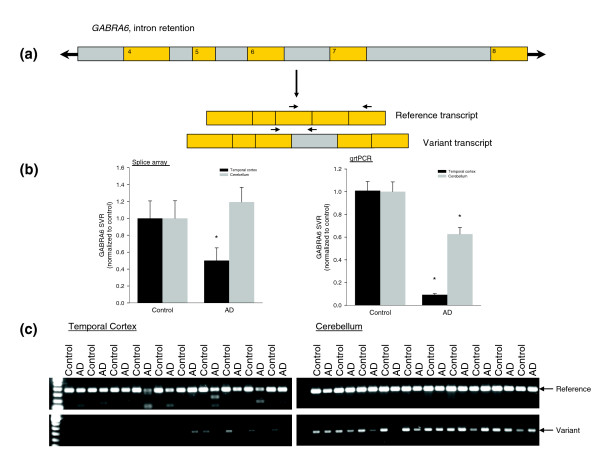
Representative AD-associated alternative splicing event identified using splice array technology. (a) Schematic of GABRA6 alternative splicing event associated with mTLE. Exons are shown in orange and intronic regions are shown in gray. (b) Data collected for the GABRA6 alternative splice event in control and AD brain tissue (TC and CB) samples using the splice array technology (left) and quantitative rtPCR (qrtPCR, right). Data are presented as mean ± standard error of the mean; *p < 0.05 when compared to control, Student's t-test. (c) rtPCR confirmation of the pattern of transcript expression in brain tissue collected from ten subjects from each group. Reference and variant transcript forms were amplified using the following primer sequences (indicated in the figure by arrows above mRNA transcripts): reference GABRA6F-AAGAATCTTCAAGCCTTCTCCA, GABRA6R-TGACAGCTGCGAACTCGATA, variant GABRA6F-AAGAATCTTCAAGCCTTCTCCA, GABRA6F-TCCAAGATTACACAAATCTTTATATGC.